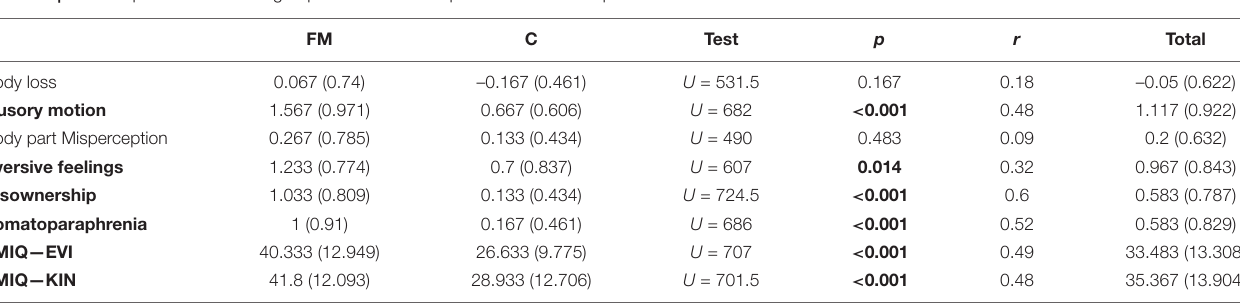
TABLE 4 | The comparison of the two groups in the BoFI components and VMIQ